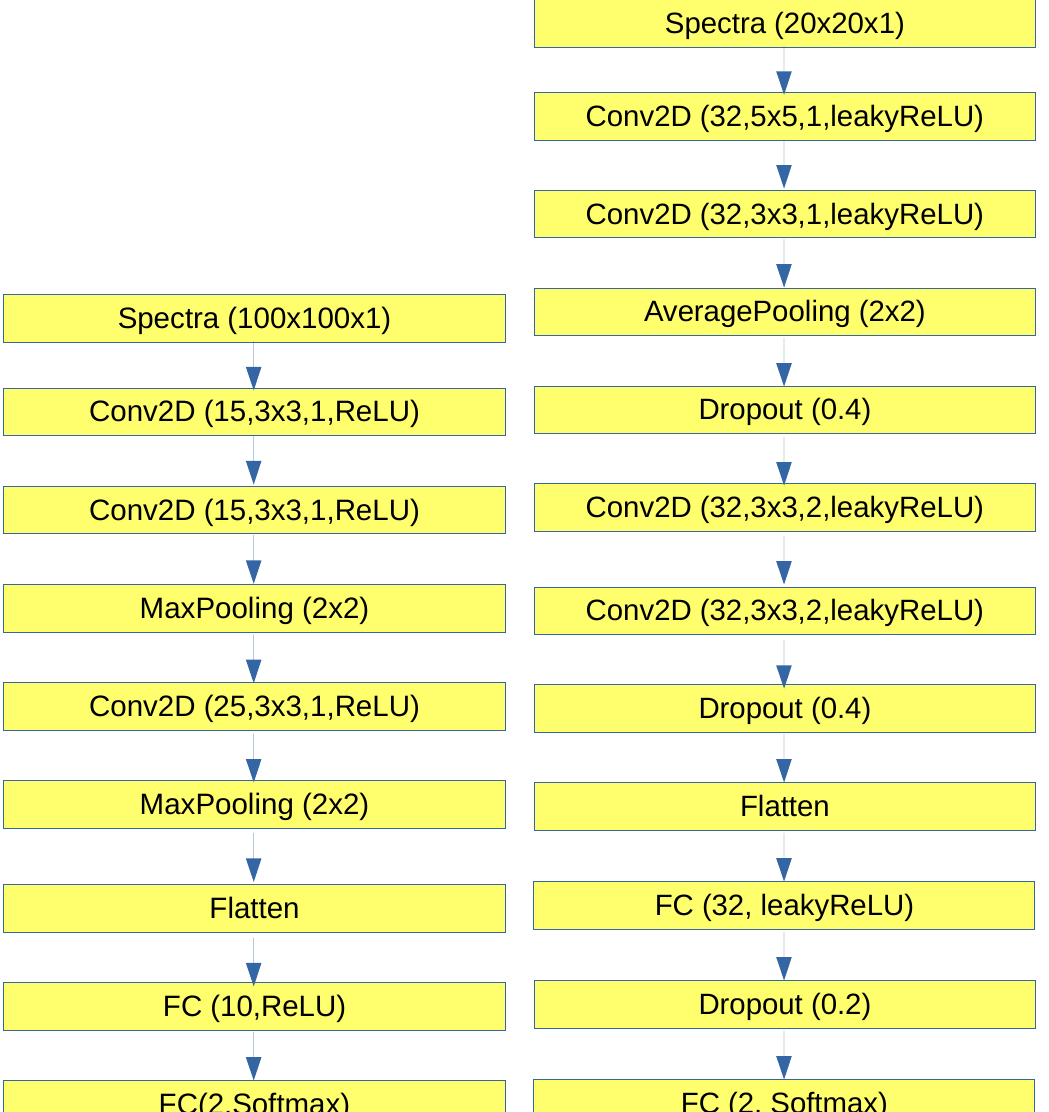
Figure 13 . Structure of the CNN used in the coordinate space analysis (left) and momentum space analysis